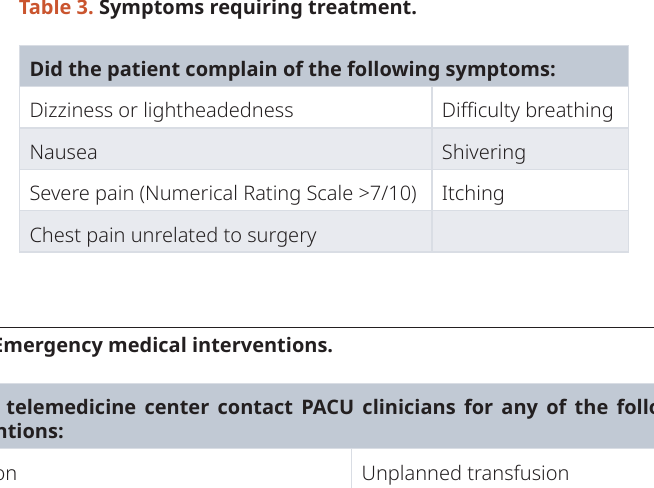
Table 3. Symptoms requiring